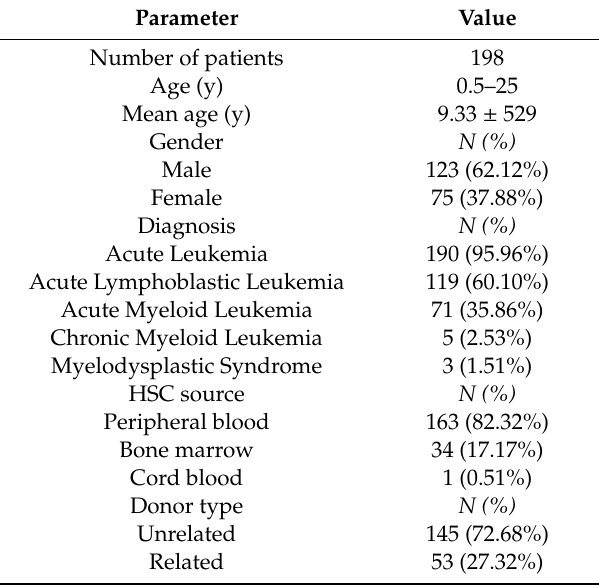
Table 1. Characteristics of the examination group.